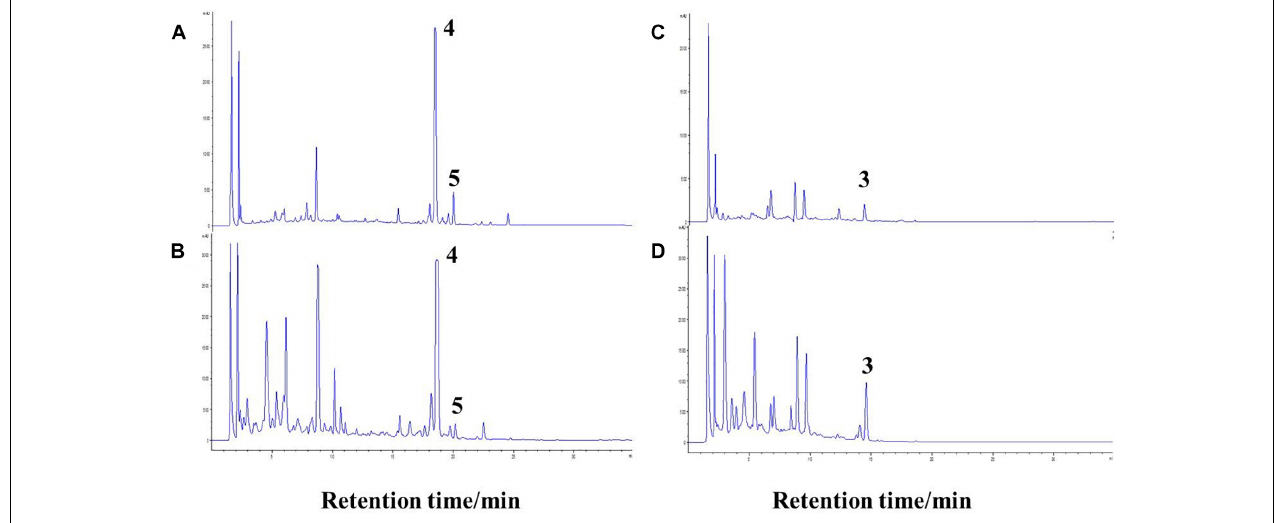
FIGURE 8 | Comparison of pure culture and co-culture. (A) Culture of S . rochei MB037; (B) co-culture of S . rochei MB037 and R . similis 35; (C) culture of R . similis 35; (D) co-culture of R . similis 35 and S . rochei